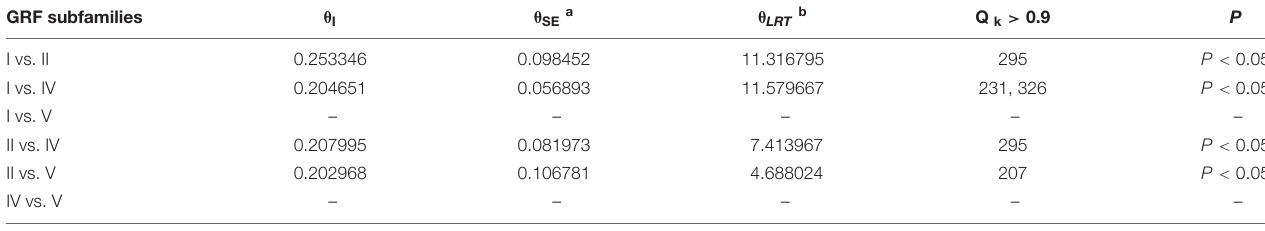
TABLE 1 | Analysis of type I functional divergence.